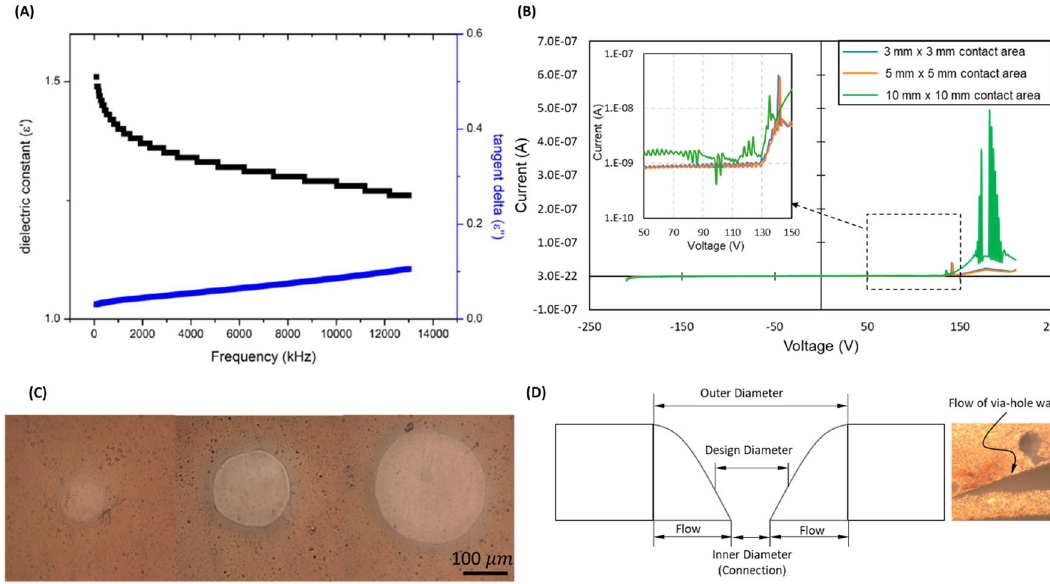
Figure 6. Insulating ink properties and via-hole printing. ( A ) Dielectric properties of the insulating ink, ( B ) IV-curve and breakdown voltage of the printed circuit, ( C ) Printed via-holes with diameters of 100, 200, and 300 μm respectively, and ( D ) printing of via-hole.